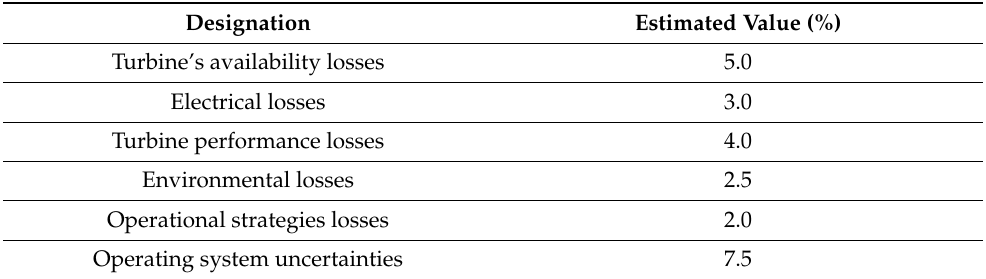
Table 2. System’s estimated losses and operating